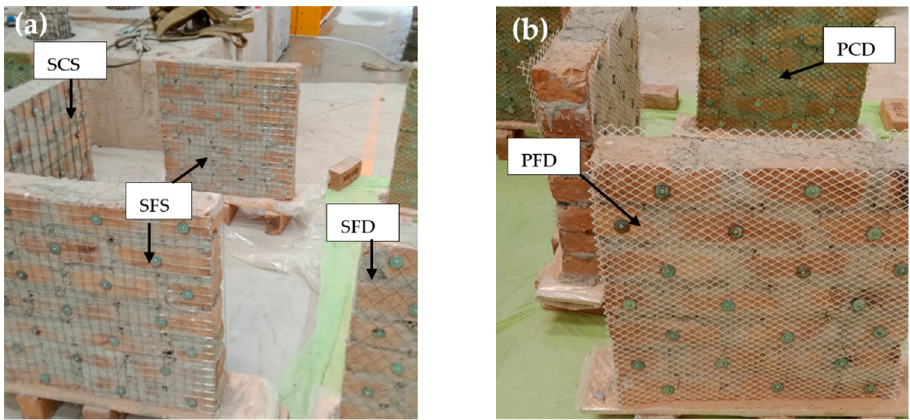
Figure 3. Pictural views of different meshing schemes. ( a ) Steel-reinforced specimens; ( b ) Plastic- reinforced specimens.